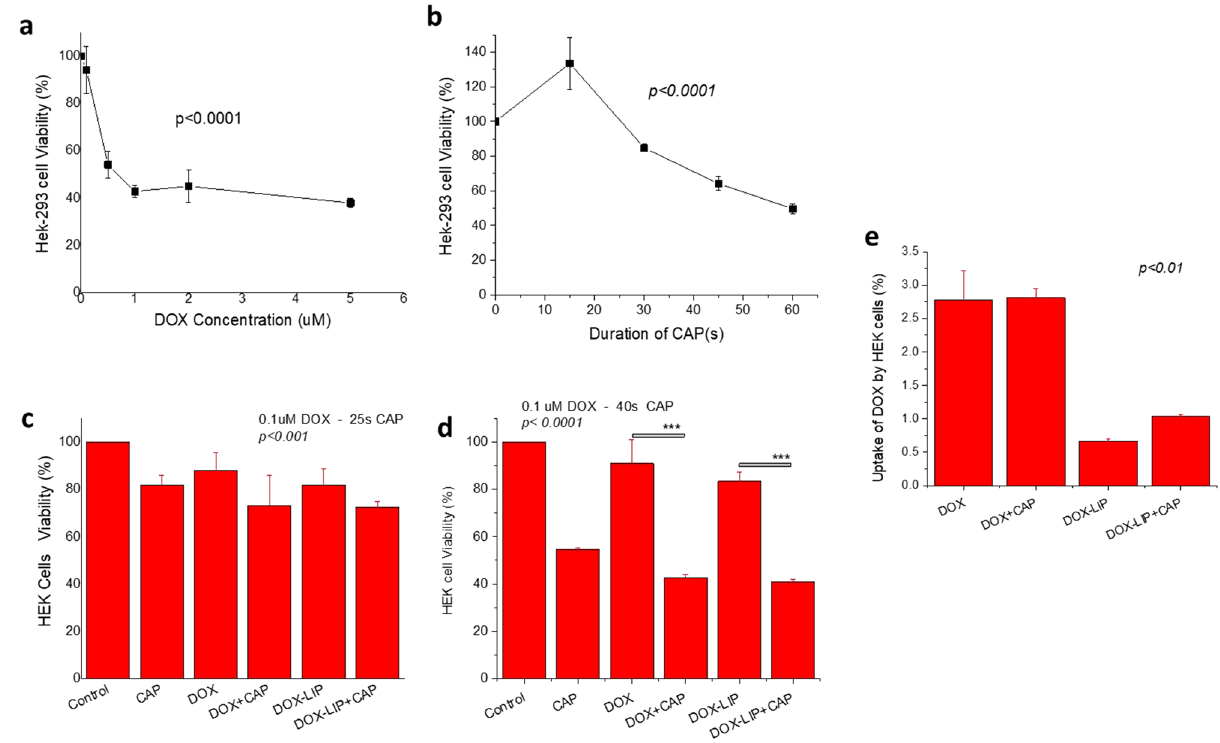
Figure 7. Effect of CAP and DOX or DOX-LIP on HEK293 cell viability. ( a ) Viability (% of control) of HEK293 cells after 48 h incubation in presence of various concentrations (0.1–5 μM) of DOX (free); ( b ) Viability (% of control) of HEK293 cells after subjection to CAP for various time periods ranging between 15 and 60 s and incubation for 48 h. ( c , d ) Effect of CAP (25 s in c and 40 s in d ) and/or DOX (free of liposomal)